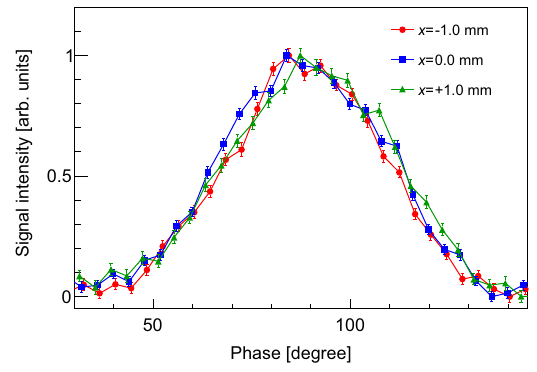
FIG. 12. Comparison of longitudinal phase distributions at typical three horizontal positions. The x means the horizontal position.